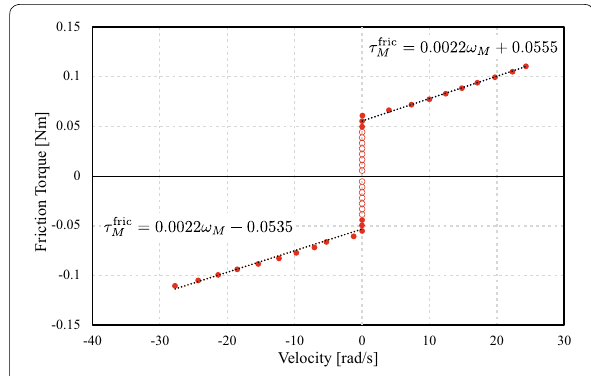
Fig. 15 Result of friction identification